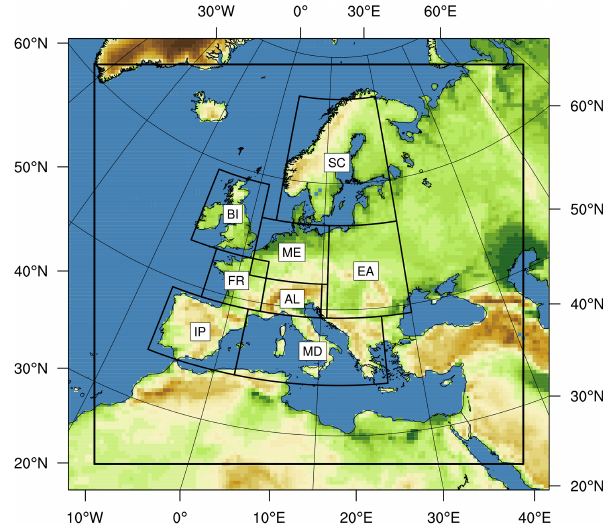
Figure 1. The European CORDEX domain used by REMO. The outermost black square shows the sponge zone. The PRUDENCE regions are depicted by the boxes with the centred two letter codes: BI – British Isles, IP – Iberian Peninsula, FR – France, ME – Middle Europe, SC – Scandinavia, AL – Alps, MD – Mediterranean, EA – Eastern